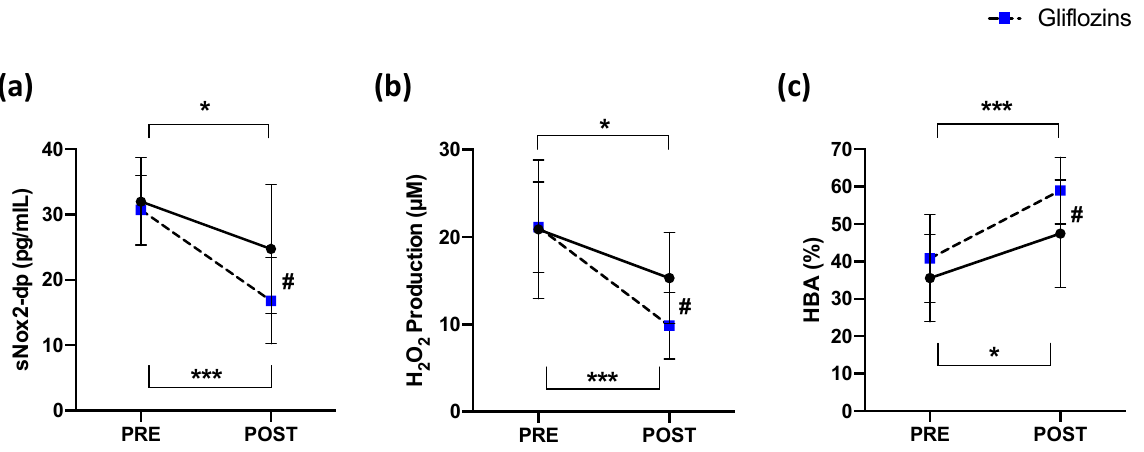
Figure 1. ( a ) Serum soluble NOX2-derived peptide (sNOX2-dp), ( b ) serum H 2 O 2 , and ( c ) blood HBA before and 15 days after administration of GLP-1RA ( n = 16) or gliflozins ( n = 16). Data are expressed as mean ± SD. Intra-group significance: * p < 0.05; *** p < 0.0001; inter-group significance: # p <